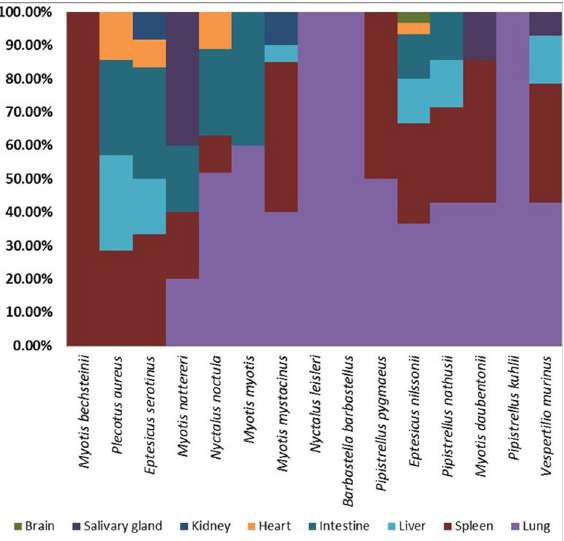
Figure 9. Percentage of individual organs pooled per species is